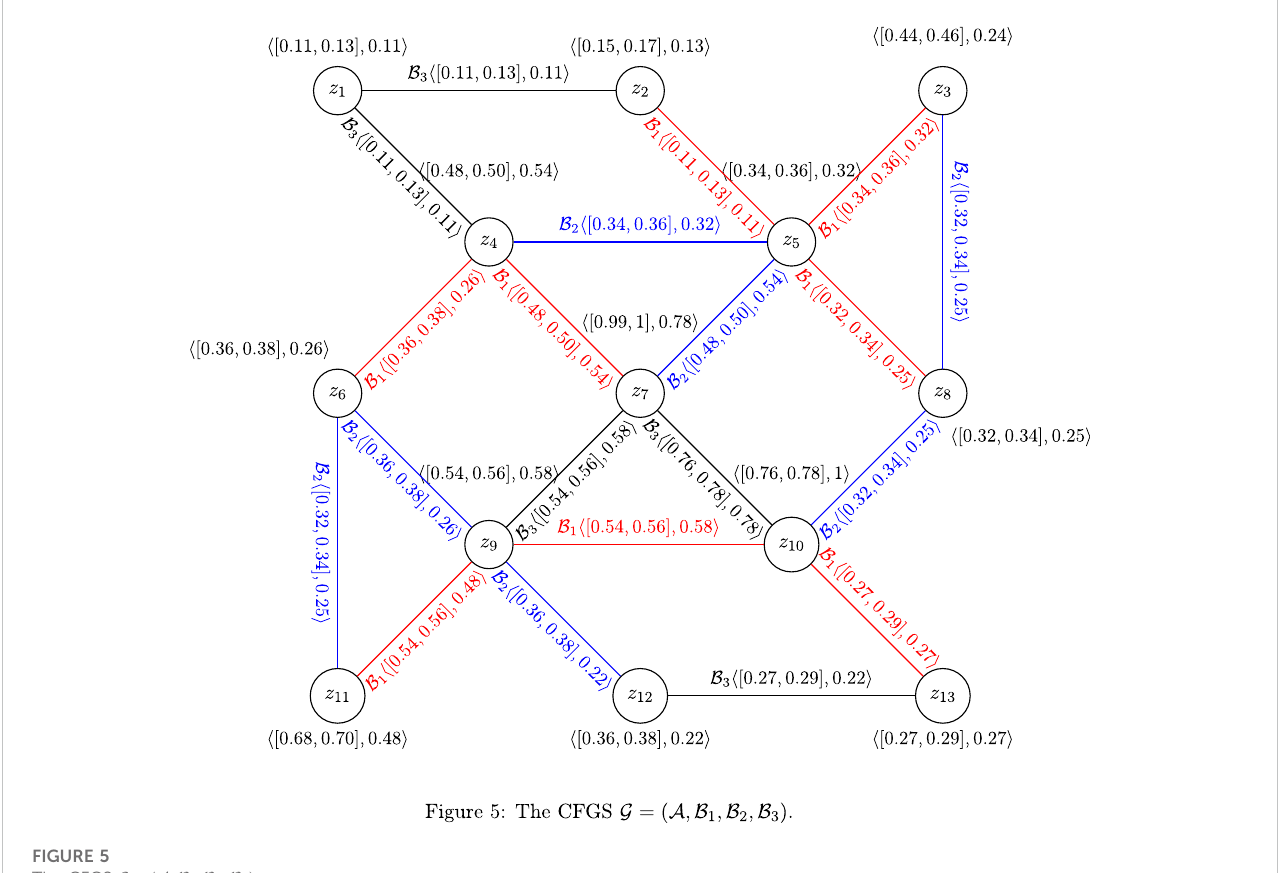
FIGURE 5 The CFGS G (cid:2) ( A , B 1 , B 2 , B 3 )